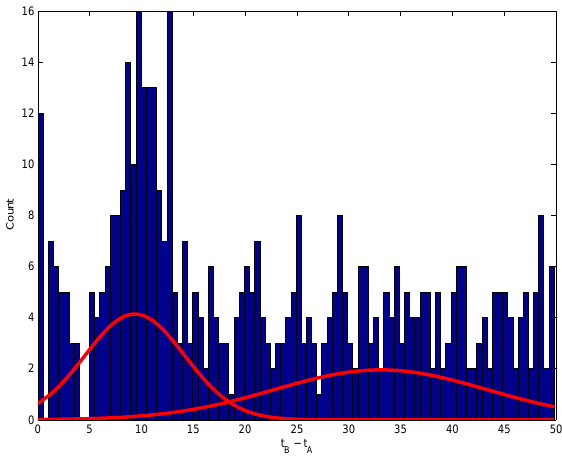
Figure 2. The distribution of the first B event after any A event. The mean and the standard deviation of the sharp Gaussian gives the critical interval for the A-B